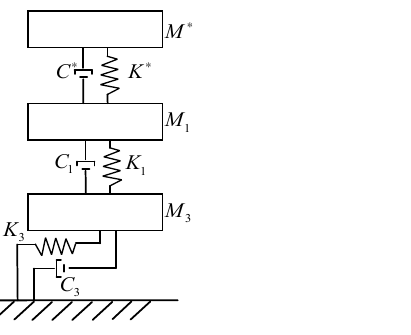
Figure 8. Simplified mechanical model of the isolation storage tank.